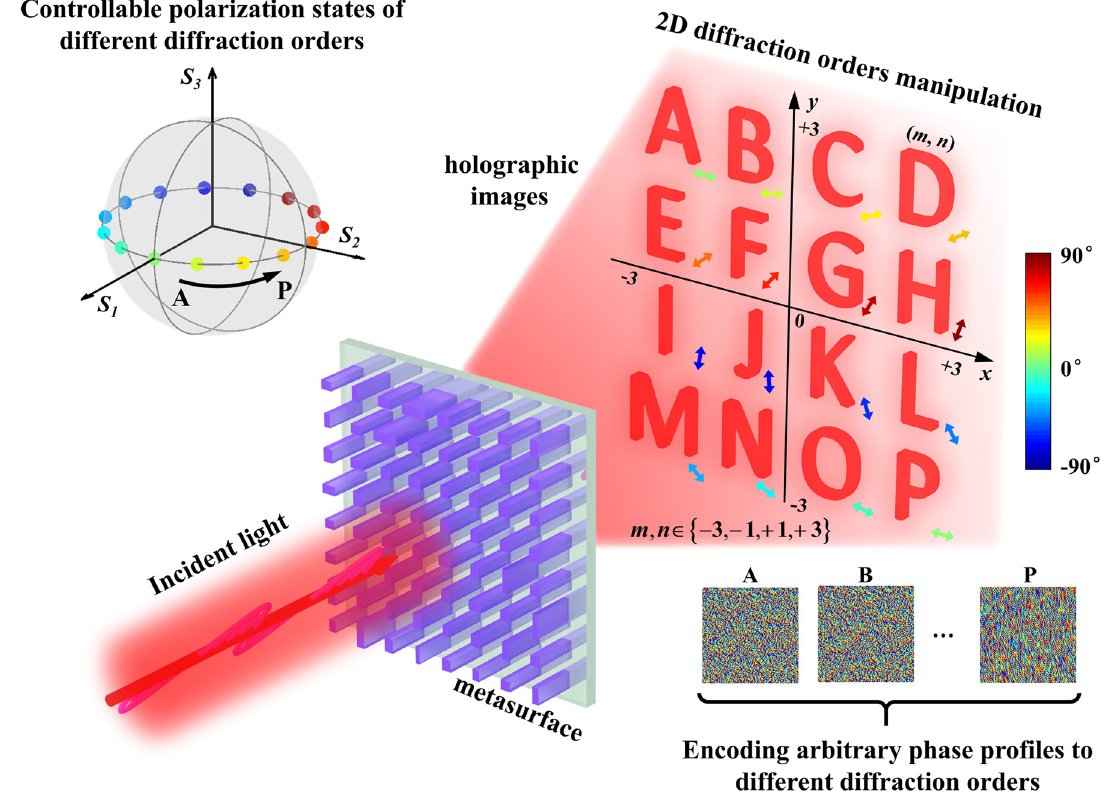
Figure 1: Schematic illustration of a dielectric metasurface with the capability of modulating multiple parameters of 2D diffraction orders simultaneously. Sixteen independent holograms are encoded to 4 × 4 uniformly distributed diffraction orders with controllable polarization states. All the holographic images exhibit linearly polarized states with different orientations that represented by the arrows with different colors. Meanwhile, the polarization states are also represented by the colorful spheres that located at the equator of the Poincaré sphere with equal